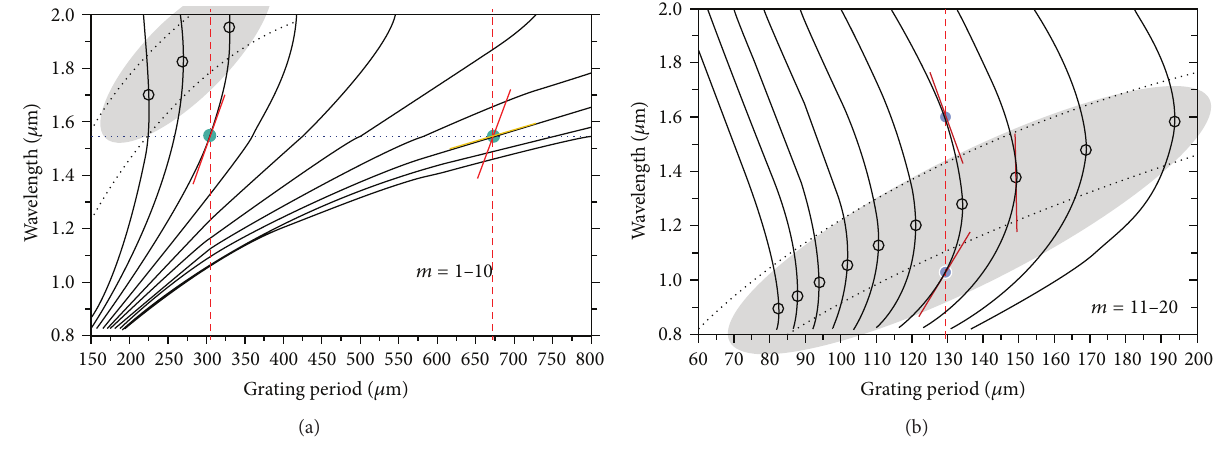
Figure 3: Phase matching curves. LPFGs turning points (adapted from